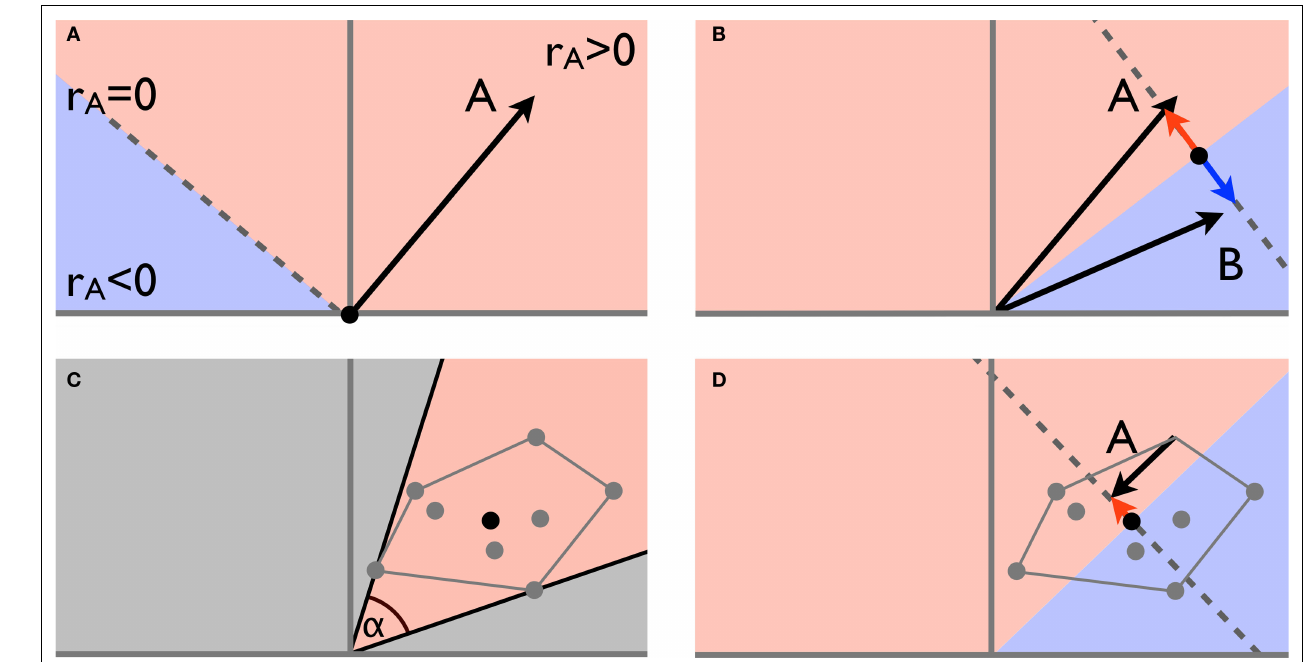
networks (grey dots) the range of possible differences in pair-wise correlations is FIGURE 4 | The vector-space illustration of global mean regression. (A) The again determined by the maximum range of the inner angles α : if α is small, pair- characteristic time series for network A can be described as a single point in a wise correlations differ by only a small amount and delineation of different high-dimensional vector space. Relative to 0 (the zero time series, black dot) the networks becomes diffi cult, in this example all pair-wise correlations are orthogonal plane (dotted line in this example) separates the vector space into an > 0) and a subspace of time series negatively positive; (D) the global mean necessarily lies within the convex hull spanned by area of positive correlation (r A all the individual characteristic time series. Global time-series regression moves correlated with A. The correlation between A and any other point is defi ned by the 0 reference point somewhere into the convex hull, thereby inevitably the (cosine of) the inner angle: all points within ± 90 ° are positively correlated inducing spurious negative correlations between the characteristic time series with A, whereas all other points are negatively correlated with A; associated with different RSNs. Global mean regression does increase the (B) when regressing out the mean of two network-specifi c time series A and B, maximum inner angle between pairs of time courses and therefore facilitates the 0 reference point is moved half-way between the two points and the original delineation of networks from each other; the resulting correlation scores (and time series get projected onto the subspace perpendicular to this mean, thereby signs thereof), however, are no longer interpretable and reference to these inducing perfect anti-correlation between A and B as the new characteristic should be vectors are now aligned at 180 ° ; (C) in the more general case of multiple